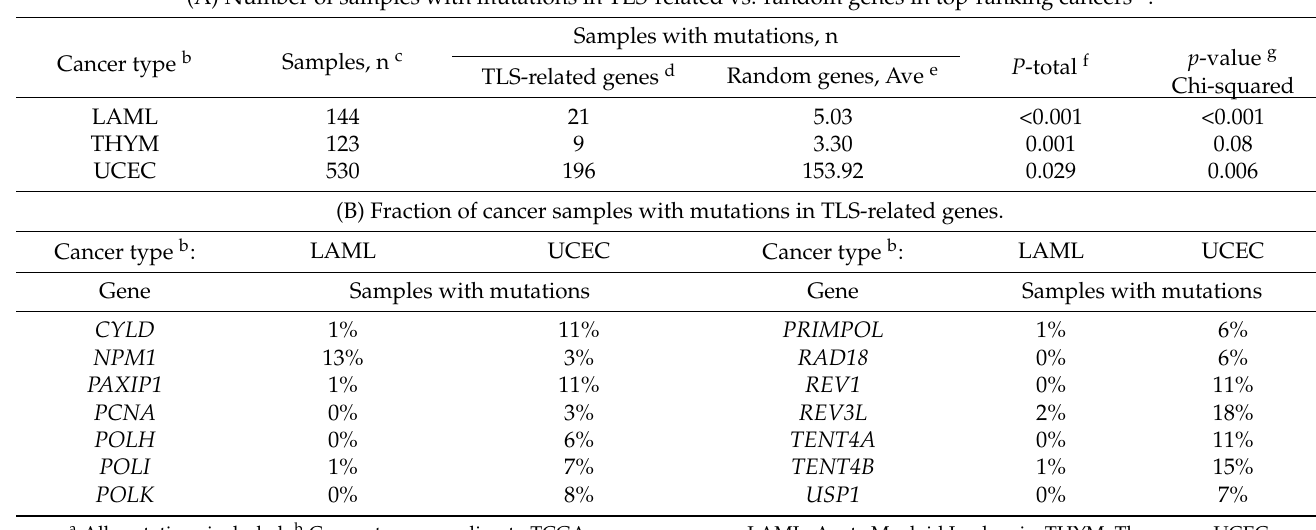
Table 1. Analysis of the frequency of TLS-related gene mutations in cancer genomes a . (A) Number of samples with mutations in TLS-related vs. random genes in top-ranking cancers a .